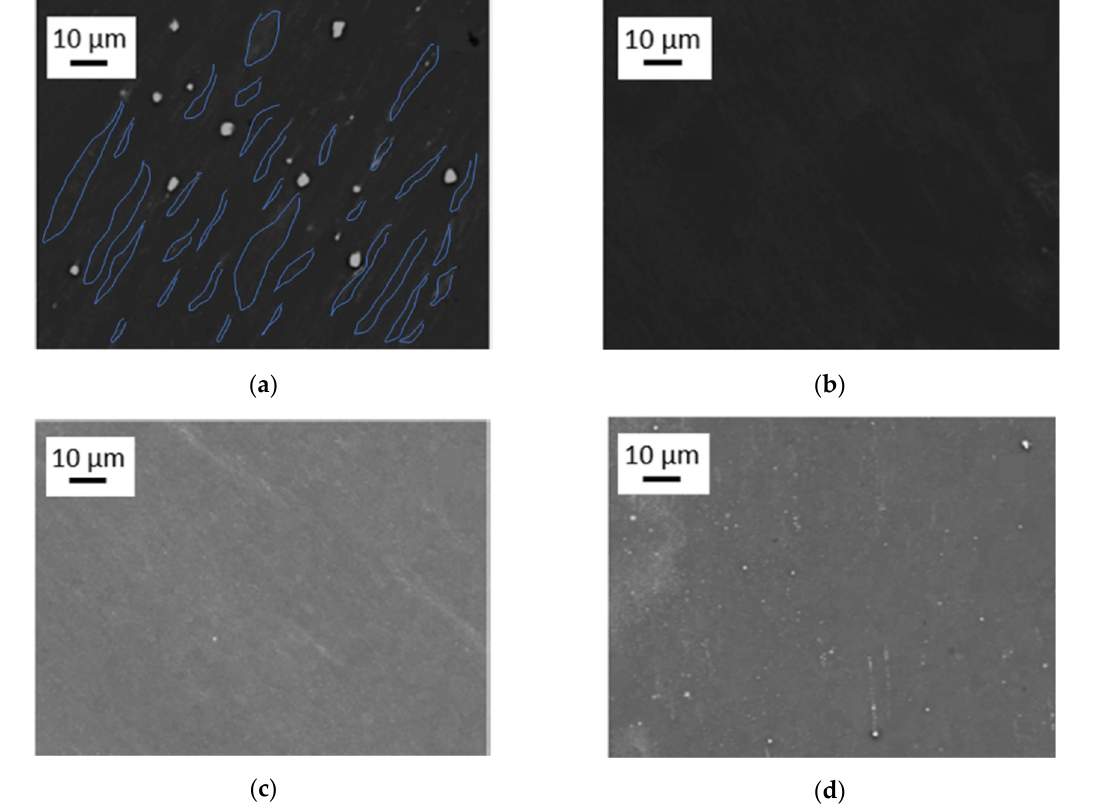
Figure 3. SEM images of high-temperature high-pressure torsion (HPT)-processed samples at 285 ◦ C, 4 GPa and 10 rotations, taken from areas with γ T ~ 320, for the materials ( a ) Mg5Zn0.3Ca, ( b ) Mg5Zn, ( c ) Mg5Zn0.15Ca, and ( d ) Mg5Zn0.15Ca0.15Zr. In ( a ), the grain area contrasts have been visualized by blue lines.